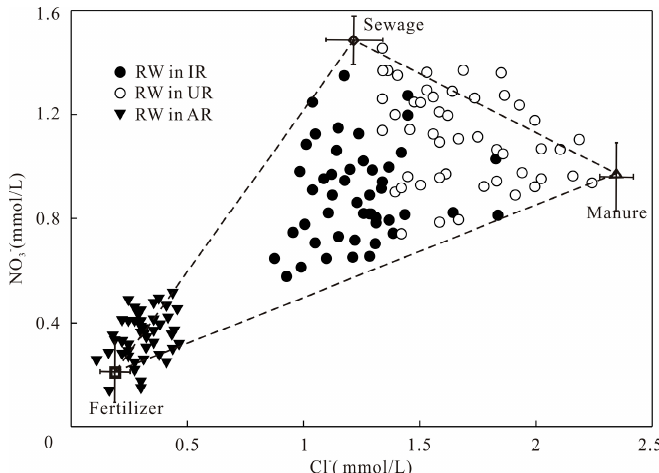
Figure 5. Mixing diagram of NO 3 − and Cl − concentrations. The means and standard deviations are shown for sewage, fertilizer, and manure. RW in IR: river water in industrial region; RW in UR: river water in urban region; RW in AR: river water in agricultural region.